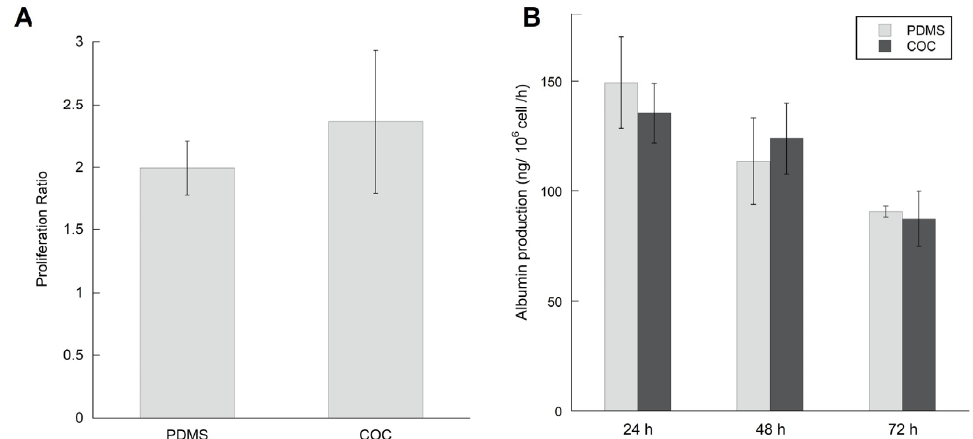
Figure 7. Proliferation and functionality of HepG2/C3a cells cultured in dynamic COC and PDMS biochips for 96 h including 24 h of adhesion and 72 h of perfusion: ( A ) Proliferation Ratio at the end of the experiment, ( B ) Albumin production after 24 h, 48 h and 72 h of perfusion.